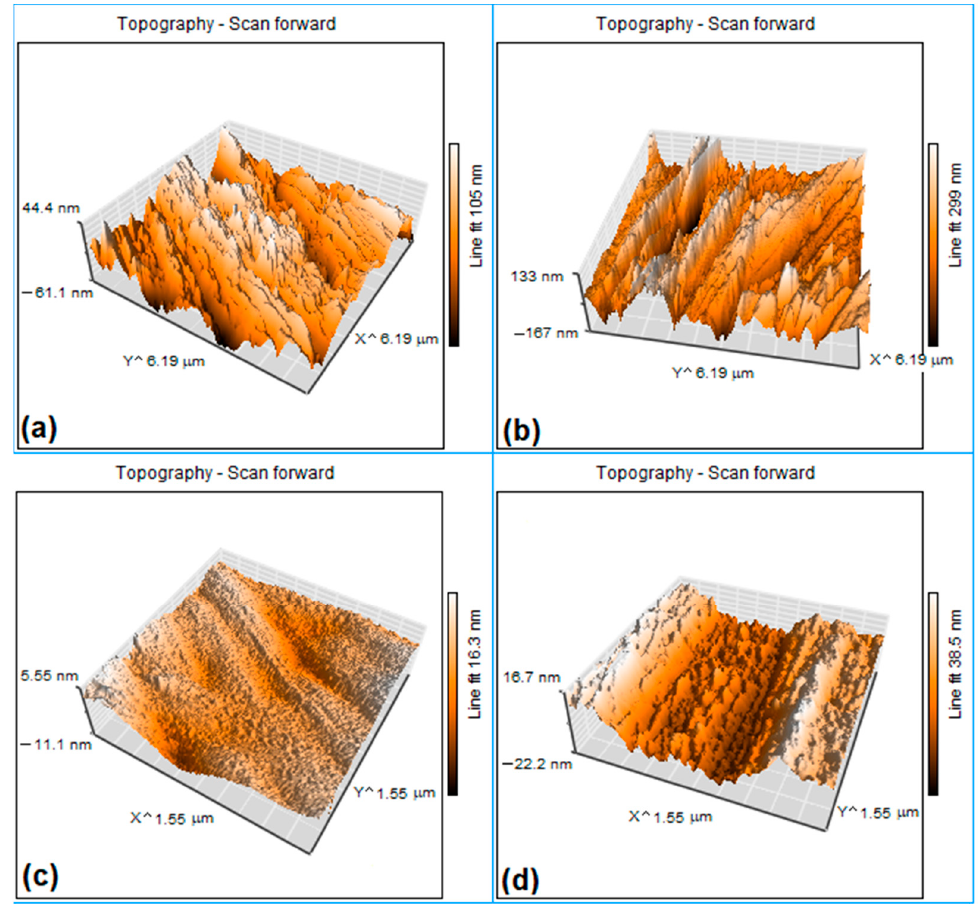
Figure 12. Typical AFM micrographs illustrating the morphology of martensite plates after a different number of FR-SME training cycles: ( a ) aspect of the convex surface after one cycle; ( b ) aspect of the concave surface after one cycle; ( c ) aspect of the convex surface after sixteen cycles; ( d ) aspect of the concave surface after sixteen cycles.